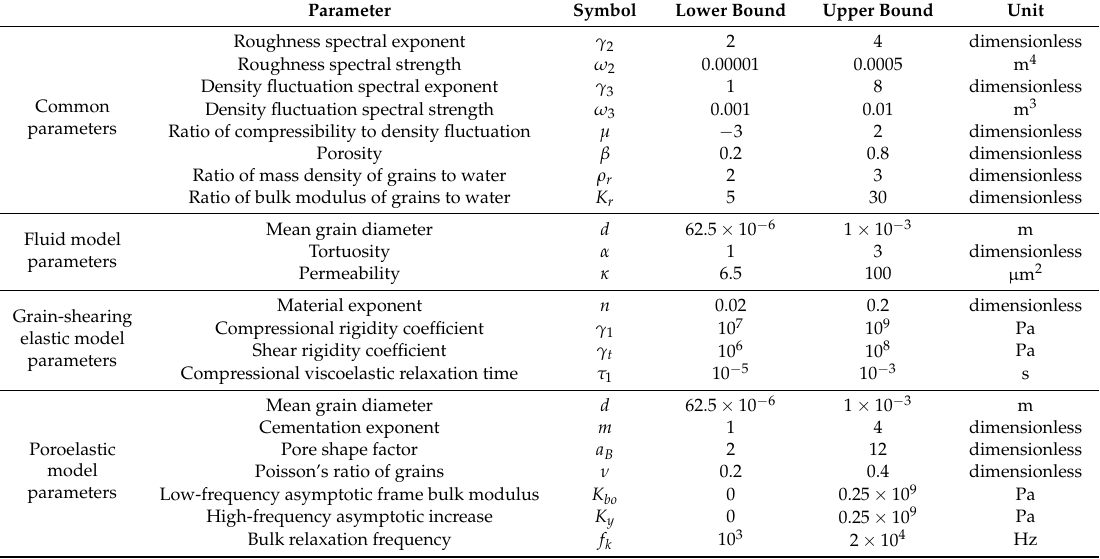
Table 1. Parameter bounds used to construct uniform priors for models’ input parameters.